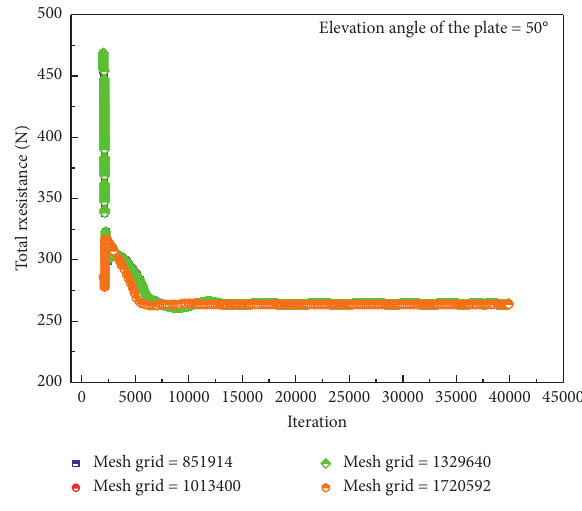
Figure 2: Grid independence